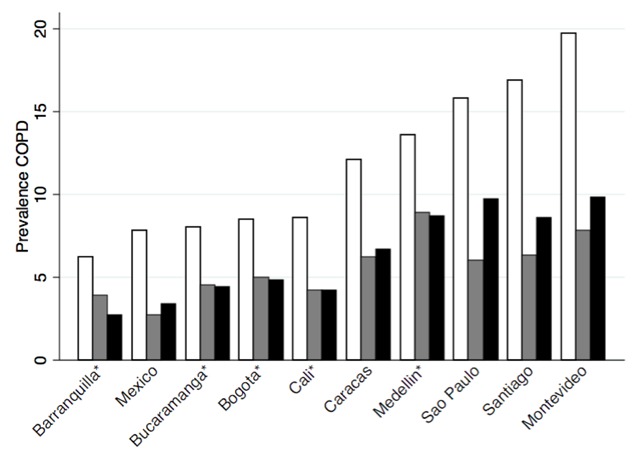
Prevalence of chronic obstructive pulmonary disease in Latin American cities by three spirometric definitions. Black bars LLN, white bars FEV1/FVC < 0.7 (global initiative for obstructive lung diseases), grey bars FEV1/FVC < 0.7 and FEV1 < 80% predicted (global initiative for obstructive lung diseases stages 2–4).